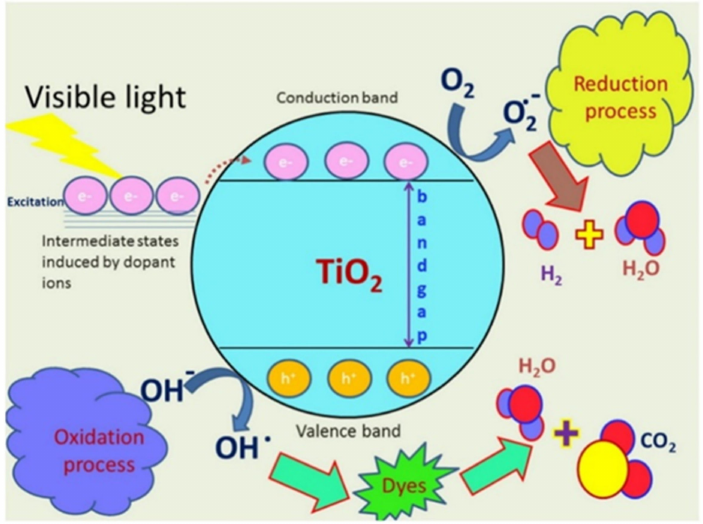
Figure 1. Mechanism of photocatalytic activity of metal-ion modified TiO 2 in the presence of visible light